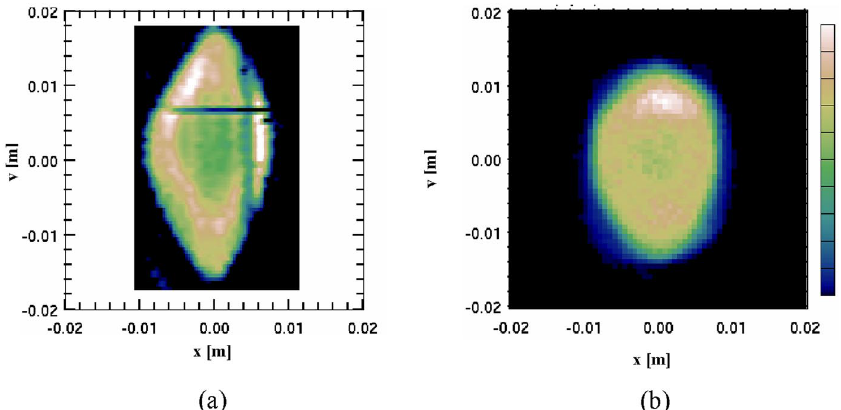
FIG. 20. (Color) Beam current density profiles J (cid:6) x; y (cid:7) at midpulse ( 2 : 64 (cid:2) s after * initialized with data at QD1, projected to a common plane in the lattice. Spatial hollowing in the center of the beam distribution is a common feature to both the data and simulation.